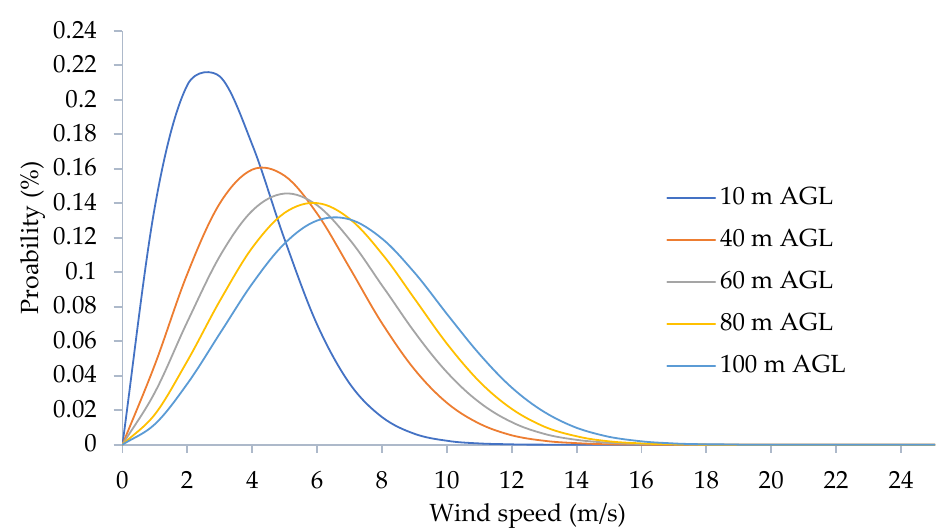
Figure 5. The Weibull probability distribution for the Monpura site at different wind shear values. From Figures 4 and 5, it can be understood that there is a clear difference between the probabilities of wind speed when its value increases significantly at different wind shear values, which tends to be capable of producing commercial-level power. For a better understanding of the wind characteristics of these two sites, the movement of predominant wind speed must also be visualized through wind rose graphs, which are presented in Figure 6.